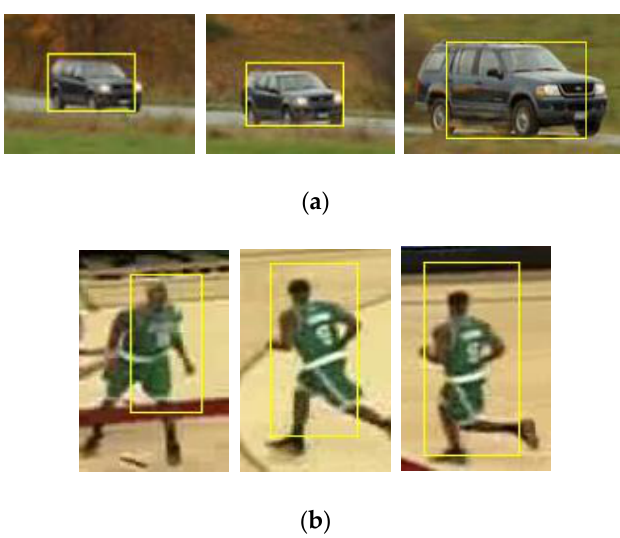
Figure 10. Introduction of the scale filter into the KCF. ( a ) CarScale sequence: the results are sampled at frame 12, 57 and 180, respectively; ( b ) Basketball sequence: the results are sampled at frame 5, 107 and 132, respectively.